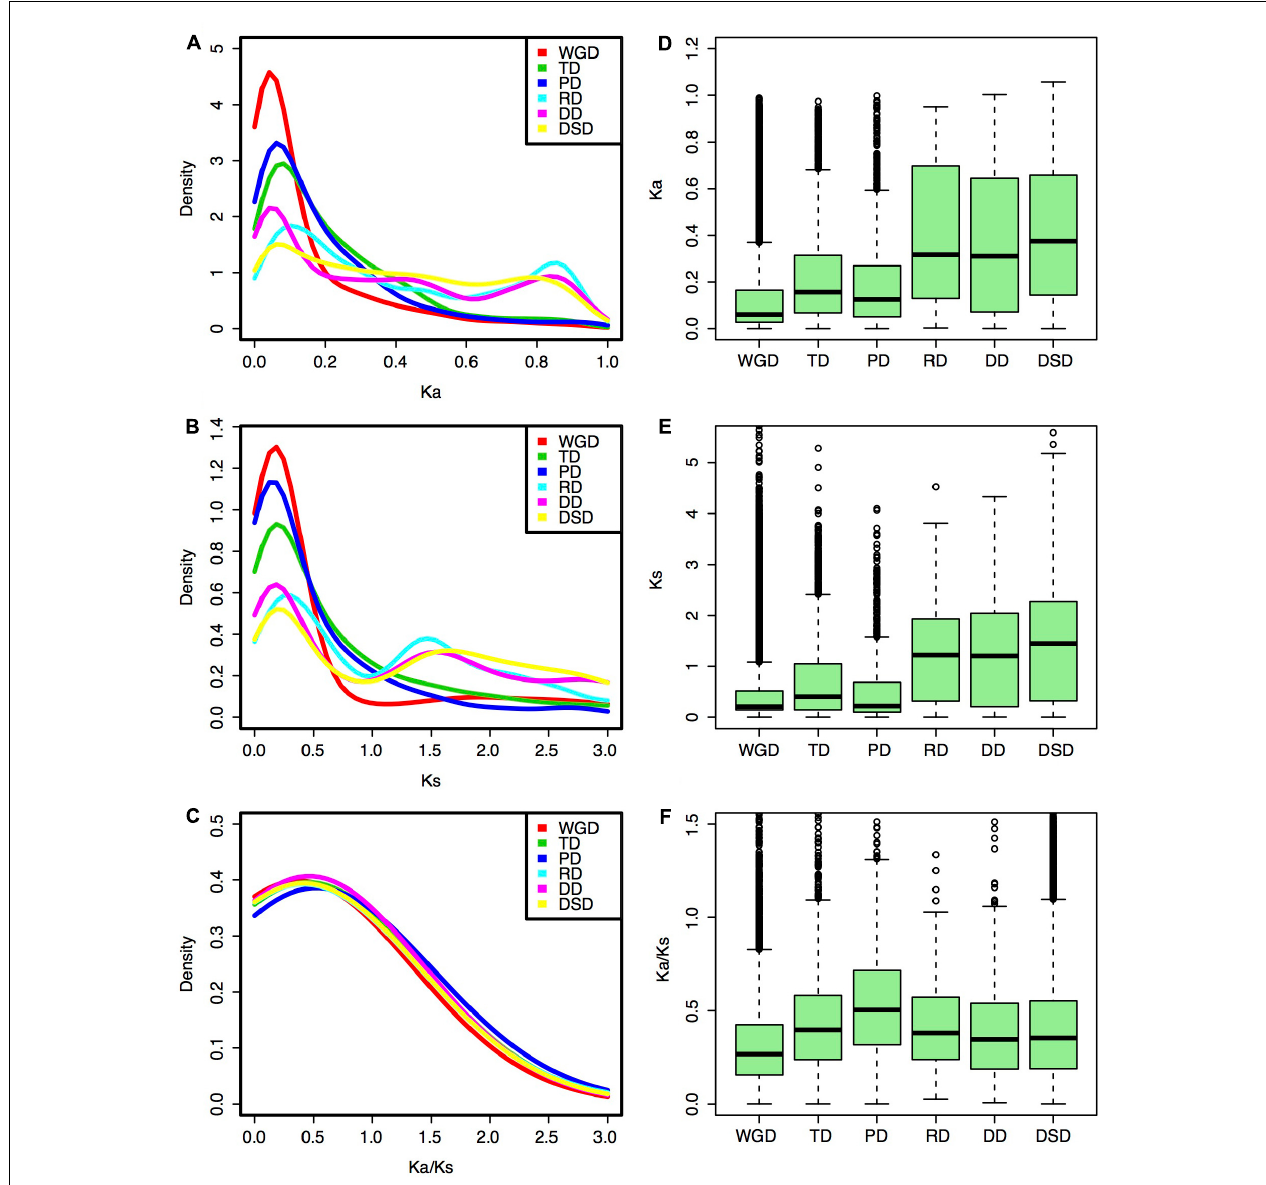
FIGURE 2 | Evolutionary patterns of gene pairs duplicated by different modes in pear. (A,D) K a distributions; (B,E) K s distributions; (C,F) K a / K s ratio distribution. (A–C) Density plot; (D–F) Box